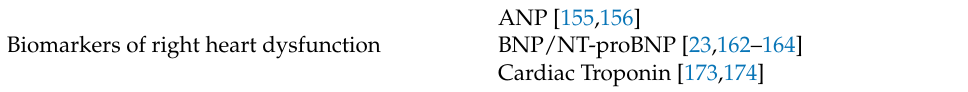
Table 4. Biomarkers of right heart dysfunction in CTD-PAH.